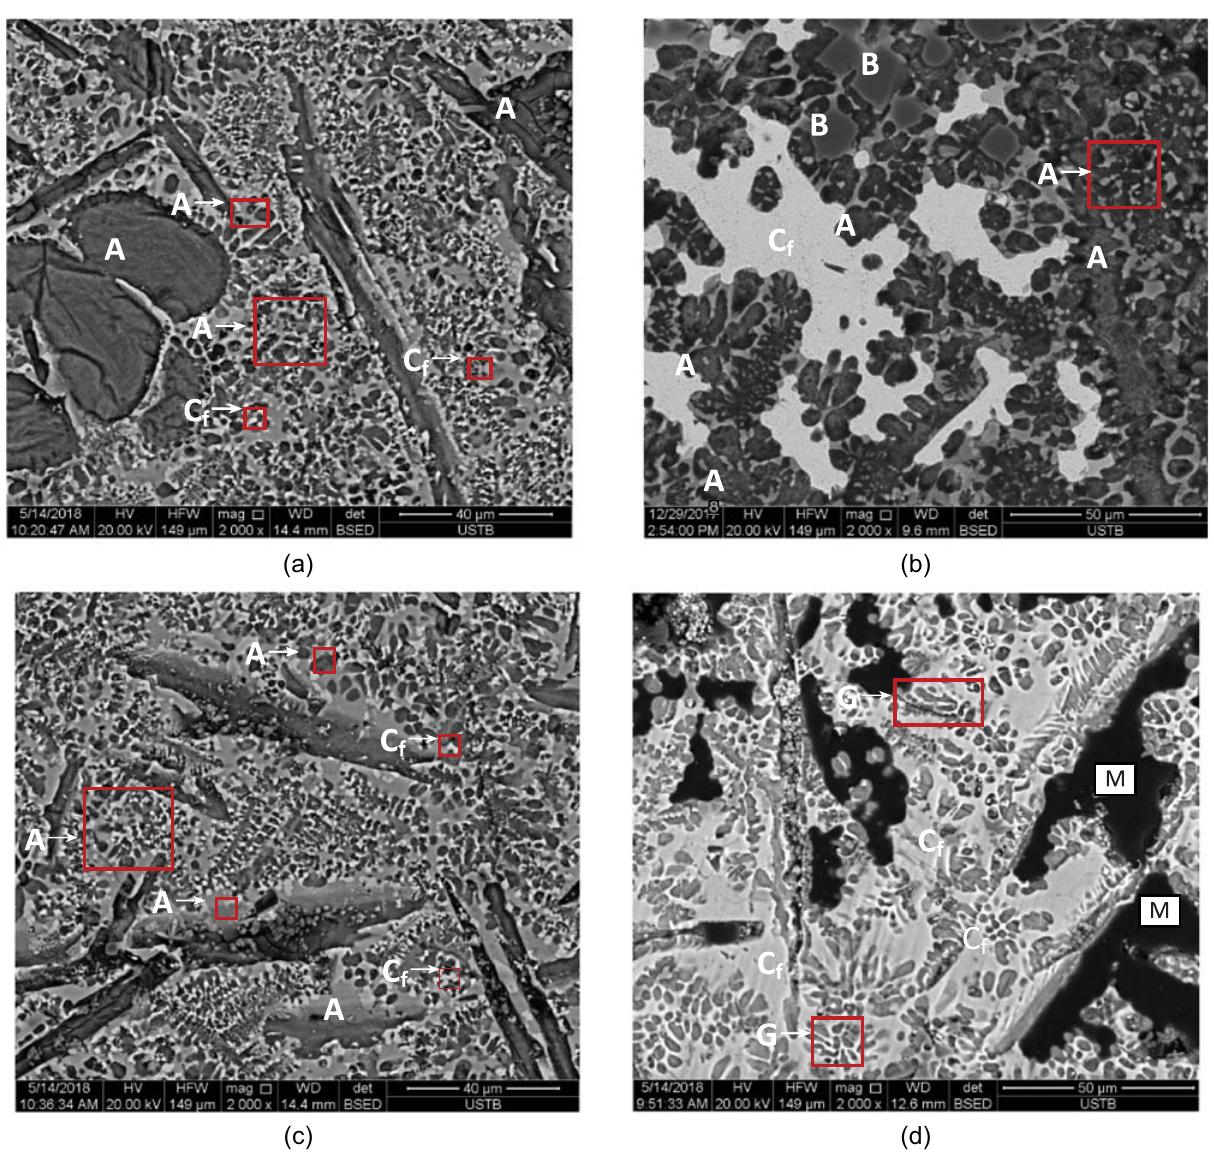
Figure 13: The results of the gasi fi cation dephosphorization slag detected by SEM. ( a ) SEM image 1, ( b ) SEM image 2, ( c ) SEM image 3, ( d ) SEM image 4.